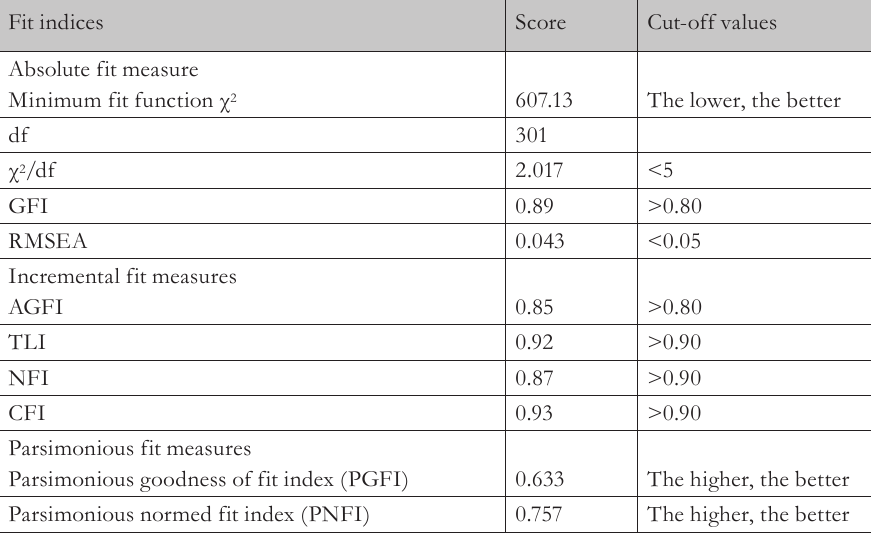
Tab. 4 – Measurement model of fit indices (Source: